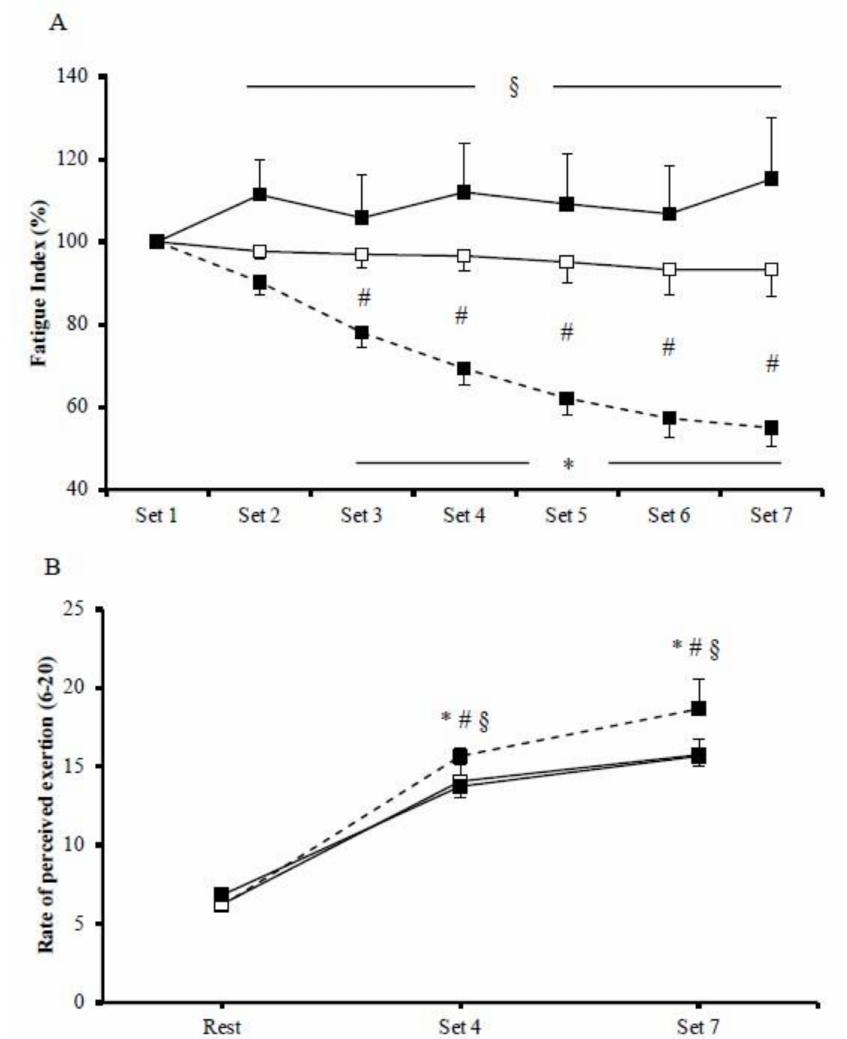
Figure 1. Fatigue index ( A ) and rate of perceived exertion ( B ) during the cycling (dash line), the concentric ( (cid:3) ), and the eccentric ( (cid:4) ) exercise. (*) indicates significant difference compared to baseline in the cycling exercise; (§) indicates significant difference between the cycling exercise and the eccentric exercise; (#) indicates significant difference between the cycling exercise and the concentric